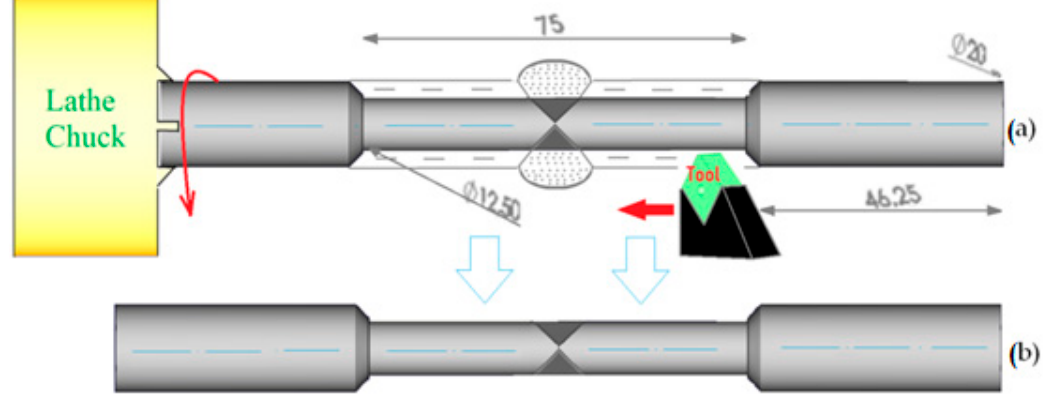
Figure 4. ( a ) Lathing process of welded rod and ( b ) ASTM E8M-04 rod specimen.